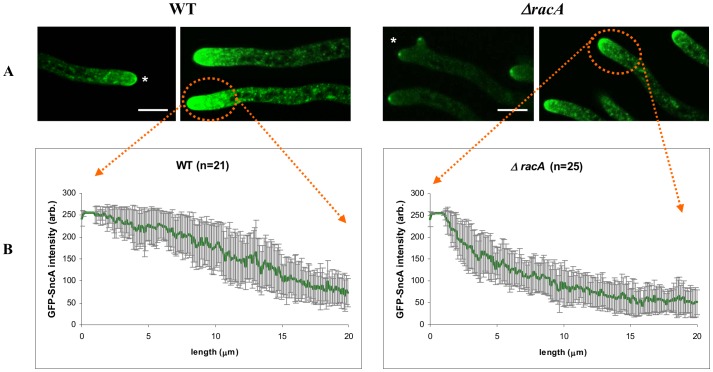
Localization of secretory vesicles and fluorescent intensity distributions in the wild-type strain N402 and the ΔracA mutant strain using GFP-SncA as fluorescent marker.(A) CLSM images showing the localization of GFP-SncA in hyphal tips. The Spitzenkörper is indicated with a star. (B) Fluorescent intensity distributions along hyphal tip compartments (n>20) within a region of 20 µm. Bar, 10 µm.